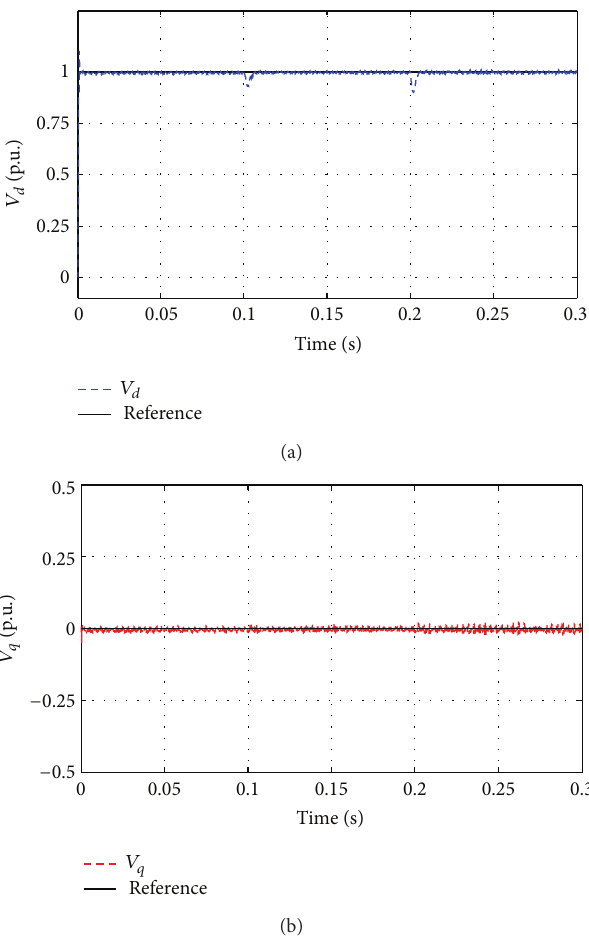
Figure 27: Response of the inverter with three load types: (a) 𝑉 𝑑 (b) 𝑉 𝑞